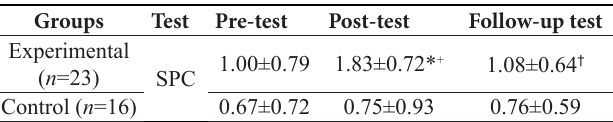
Table 3. Observation of the Seated Posture in the Classroom (SPC).